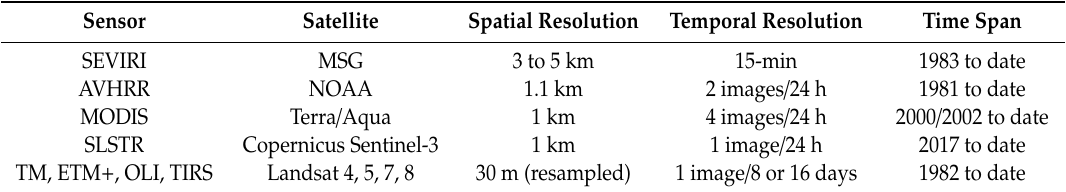
Table 1. Characteristics of several satellite remote sensing products delivering LST data. Sensor